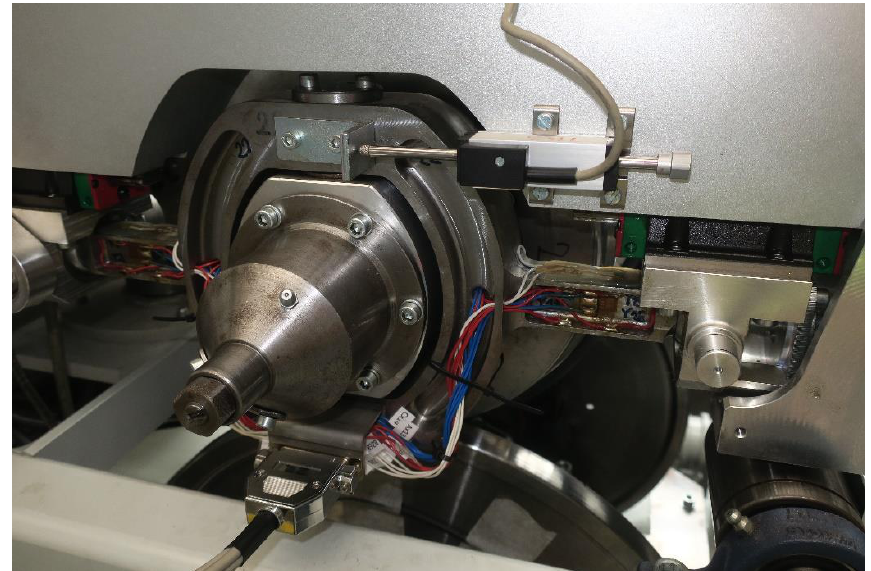
Figure 17. Instrumented stirrup.